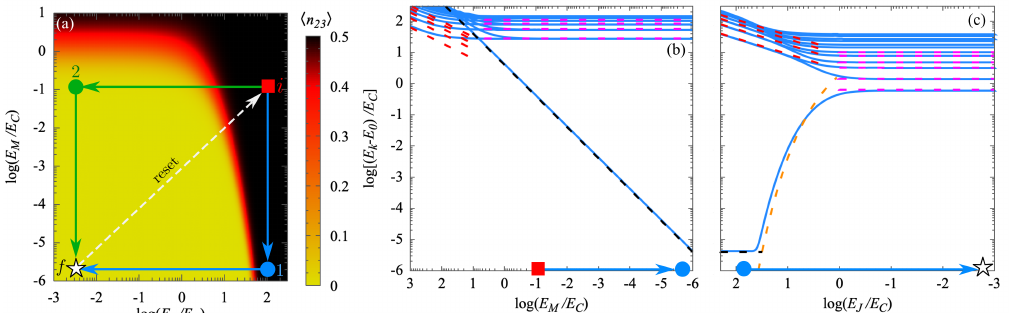
Figure 3: (a) Island MBSs parity in the ground state as a function of E and E . J M The red square represents the initial configuration ( i ) where the island is coupled to the TS leads and the JJ FET is open. The blue (green) arrows correspond to the fusion (reference) protocol, where the dot is an intermediate step where the island is decoupled from the bulk superconductor (TS leads). In the final configuration, white star ( f ), the island is isolated. Panels (b) and (c) represent the excitation energies from the ground state in the total even parity subspace when decoupling the TS leads and the JJ FET, following the fusion path. The same energies are found for the total odd parity subspace. Solid lines correspond to numerical results while the dashed lines are approximations in the different regimes (details are given in the text). We = 100 E = E / 100, E max = 0.4 E = 10 − 6 E = use E max , E min , E min , and n C C C C g J J M M